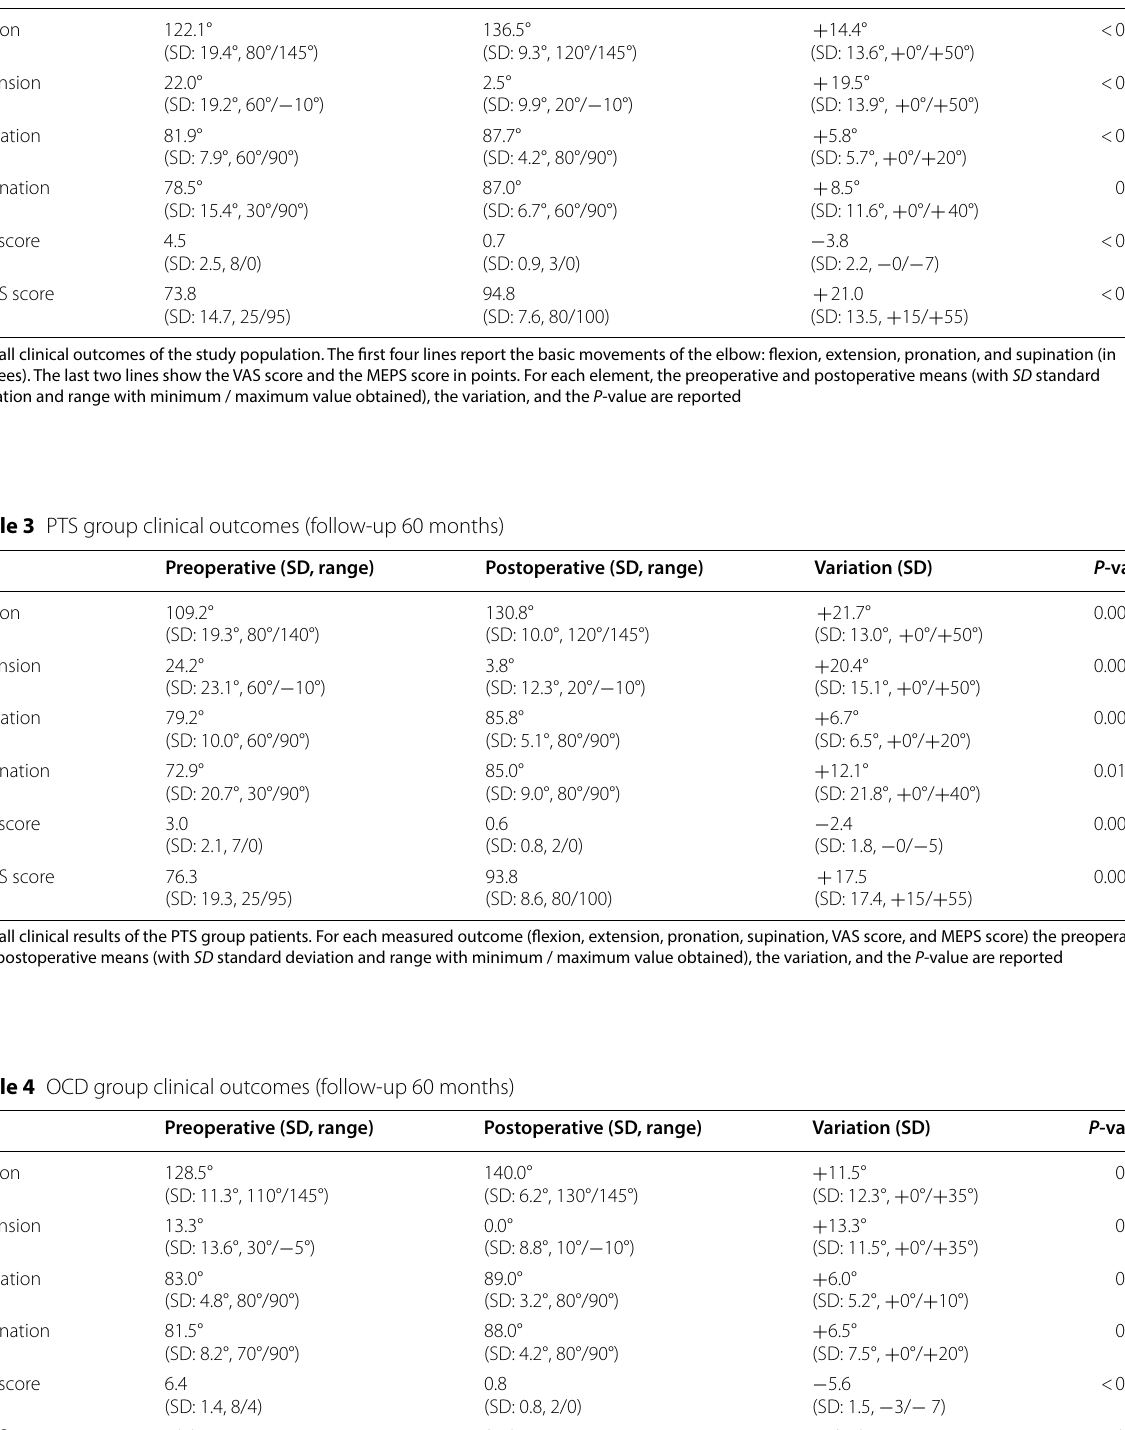
Table 2 Total study population clinical outcomes (follow-up 60 months)